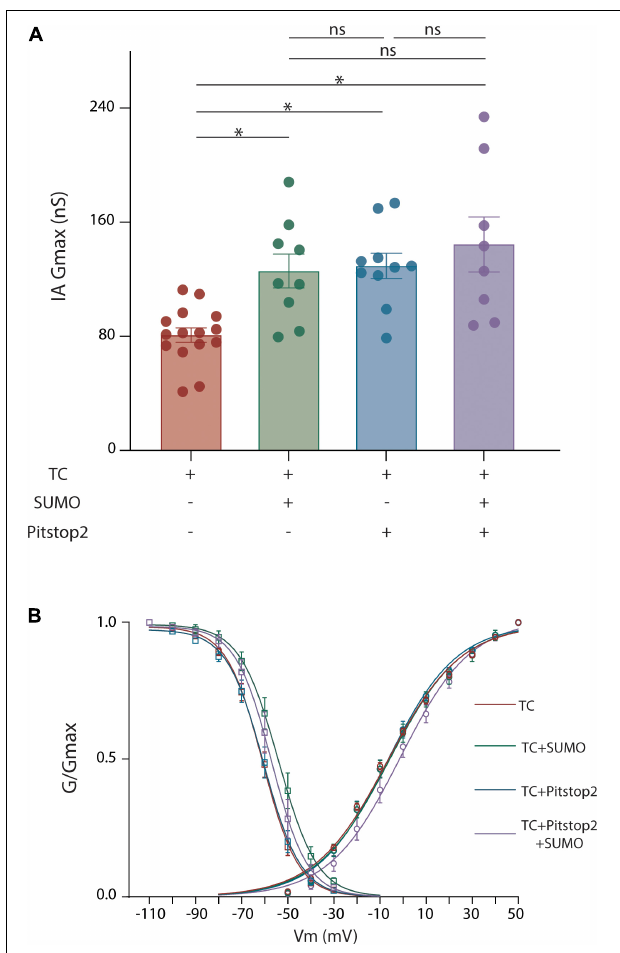
FIGURE 6 | Blocking endocytosis mimics and occludes the effects of Kv4.2 K579 SUMOylation. HEK cells were transiently transfected with plasmids encoding the three TC components. Whole cell patch clamp recordings were performed on transfected cells with and without SUMO(2 or 3) peptides in the patch pipette and Pitstop2, a cell permeable endocytic inhibitor, in the superfusate. (A) Plot showing the mean ± SEM IA Gmax for each treatment group. Asterisks indicate significance. One-Way ANOVA with Tukey’s post hoc , F (3,38) = 8.013, p = 0.0003; TC: 80.87 ± 5.1 nS, TC + SUMO: 125.8 ± 11.8 nS, TC + Pitstop2: 129.4 ± 8.9 nS, TC + Pitstop2 + SUMO: 144.4 ± 19.2 nS. (B) Activation (circle) and steady-state inactivation (square) curves for each treatment group. Each data point represents the mean ± SEM for all data points analyzed. There was no significant difference in the voltage dependence across treatment groups: V50 act, F (3,39) = 0.358, p = 0.784; V50 inact, F (3,42) = 2.70, p = 0.0578.